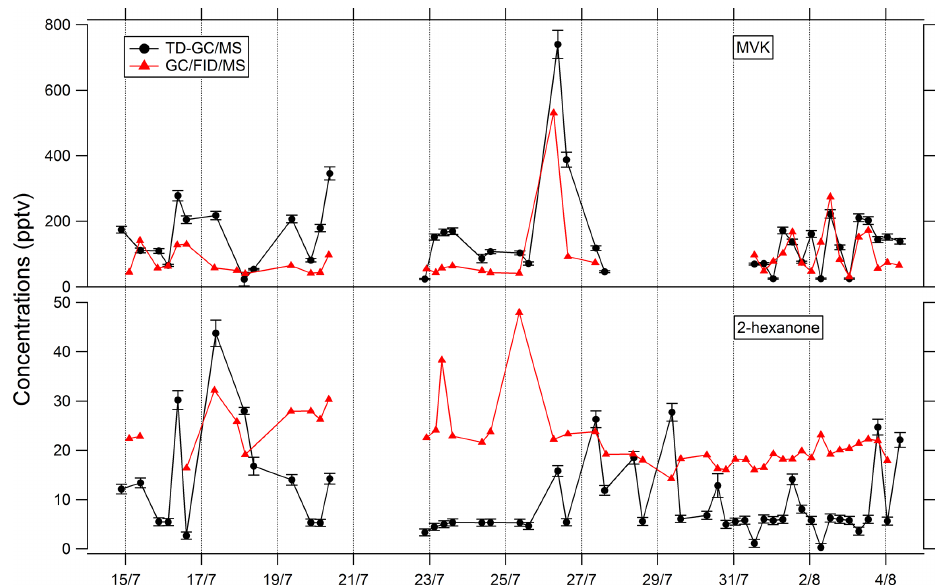
Figure 5. Comparison of ATD–GC–MS data with GC–FID–MS data averaged over the same time step for methyl vinyl ketone and 2- hexanone. Error bars correspond to the 1 σ uncertainties in TD–GC–MS